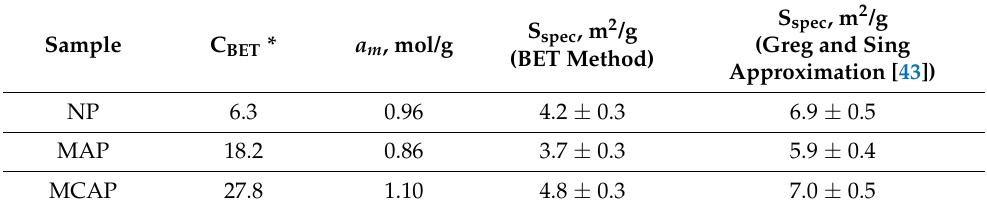
Table 3. Surface properties of natural peat (NP), mechanically activated peat (MAP), mechanochem- ically activated peat (MCAP).